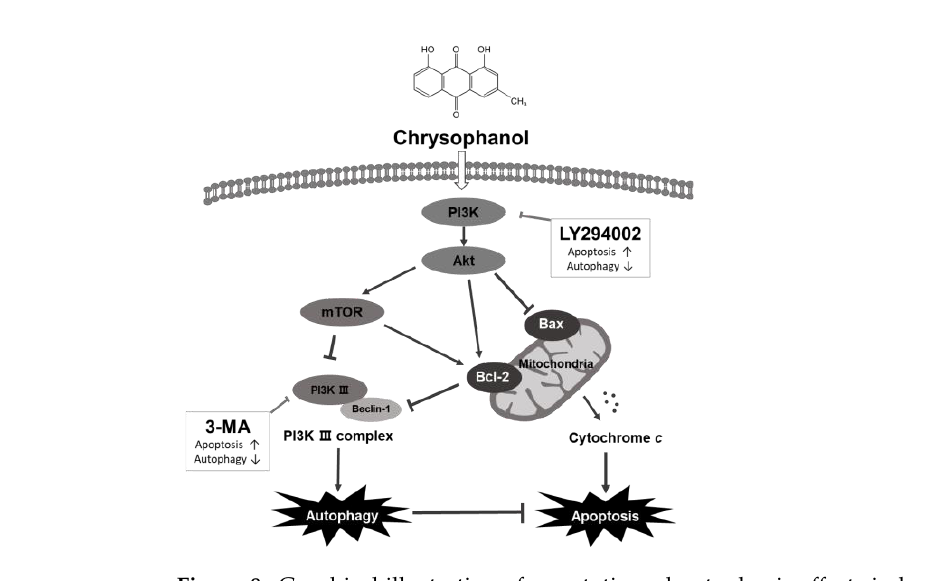
Figure 8. Graphical illustration of apoptotic and autophagic effects induced by chrysophanol in human OSCC, CAL-27 and Ca9-22 cells. Chrysophanol activates autophagy and in parallel inhibits apoptosis activity. 3-MA, an autophagy inhibitor, inhibits autophagy and cooperates with apoptosis, which is occasioned by chrysophanol. Inhibition of the PI3K/Akt/mTOR signaling pathway with the PI3K inhibitor LY294002 enhances chrysophanol-induced apoptosis and reduces autophagy. Therefore, chrysophanol-induced autophagy acts as a cell protection mechanism and interferes with the apoptosis pathway of OSCC cells.